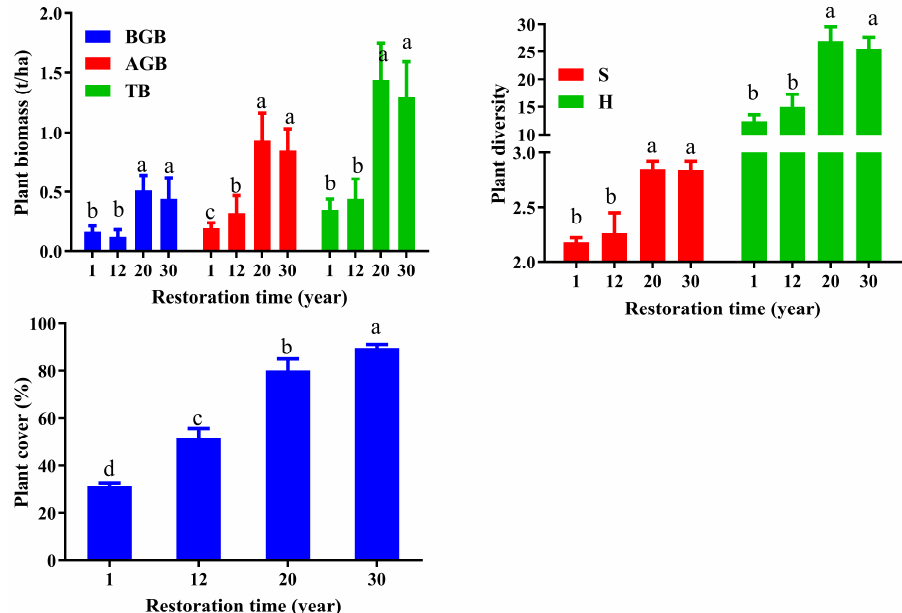
Figure 2. The characteristics of the vegetation across the succession (mean ± standard deviation, n = 9). AGB, above-ground biomass; BGB, below-ground biomass; TB, total biomass; S , species richness index; H, Shannon diversity index. Different letters indicate significant differences between vegetation sites ( p < 0.05).